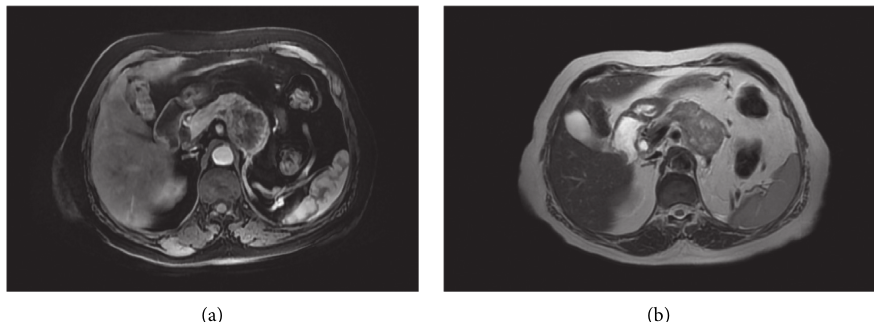
Figure 2: MRI images of T1 fat saturation sequences with gadolinium injection in arterial (a) and portal (b) phases showing a tissular corporeal pancreatic mass, with low signal, enhanced in periphery, comprising a necrotic center with no involvement of the superior mesenteric artery.